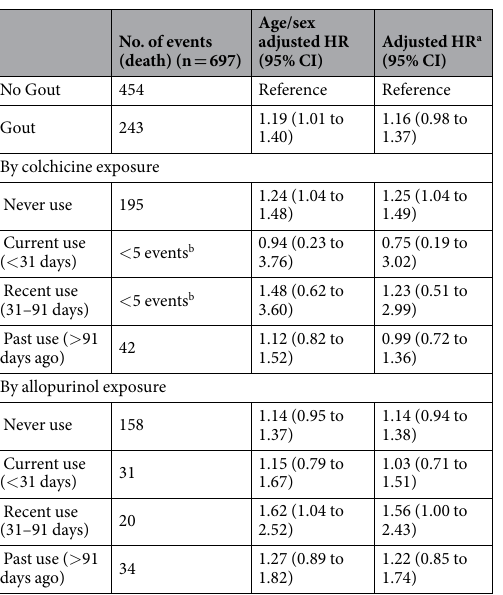
Table 5. Risk of infection-related mortality due to UTI, in patients with gout compared to matched controls, stratified by use of colchicine and allopurinol. Abbreviations: HR: indicates hazards ratio; CI, confidence interval; PY, person years. (a) Adjusted for age, sex, body mass index, smoking status, alcohol use, the most recently recorded estimated glomerular filtration rate in the past year, a history of dementia, dysphagia, stroke, epilepsy, ischaemic heart disease, sepsis and the use of bronchodilators, inhalation corticosteroids, systemic corticosteroids, non-insulin anti-diabetic drugs and insulin within 6 months before. (b) According to Independent Scientific Advisory Committee (ISAC) guidance on the content of protocols for research using CPRD data no cell containing < 5 events are